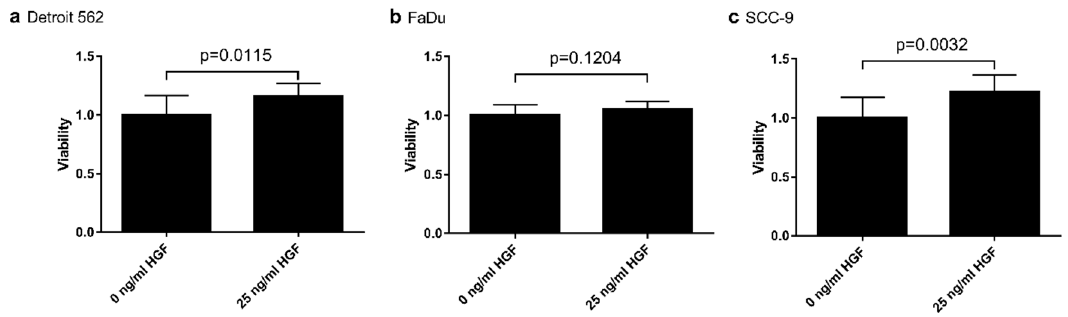
Figure 3. Effect of HGF on proliferation of cell lines Detroit 562 ( a ), FaDu ( b ), and SCC-9 ( c ). Cells were treated with or without HGF for 72 h. Afterwards, cells were stained with crystal violet, and absorption at 595 nm was measured. Result of untreated cells was set as one.